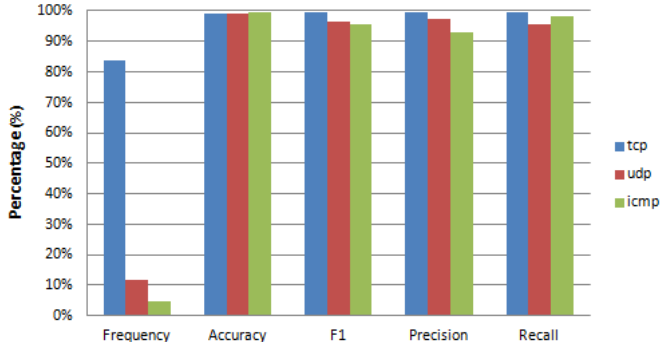
Figure 9. Performance metrics (One vs. Rest) for reconstruction of all features values when feature: ‘protocol’ is missing.